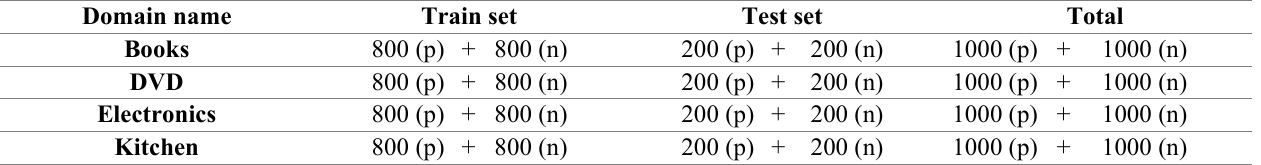
Table 4. Train-Test data description